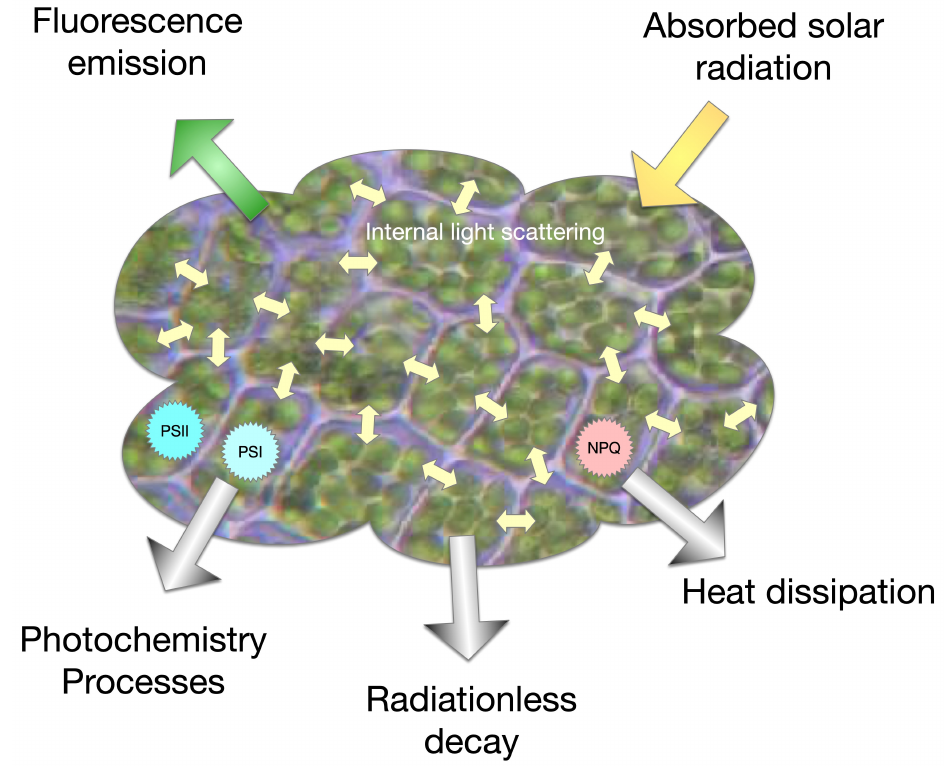
Figure 6. Conceptual illustration of the distribution of absorbed solar radiation in plant leaves, adapted from Frankenberg et al.